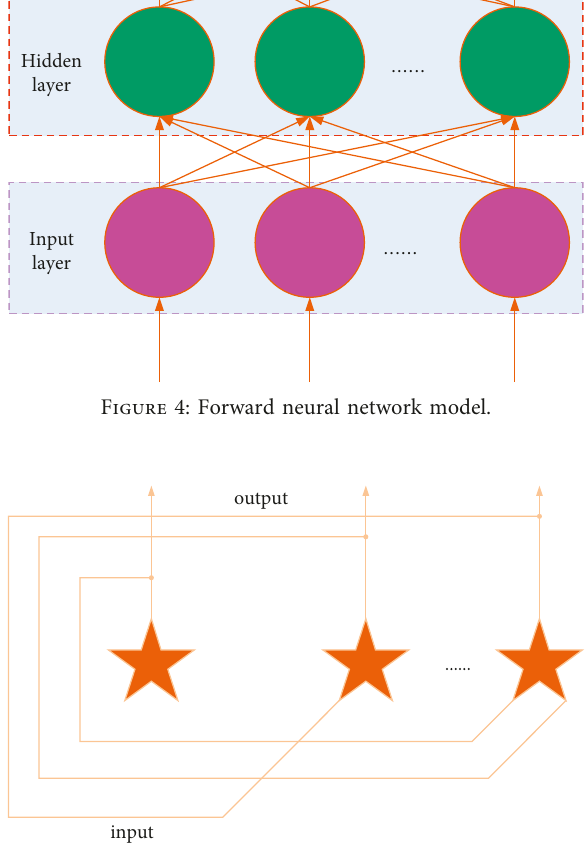
Figure 5: Feedback neural network.